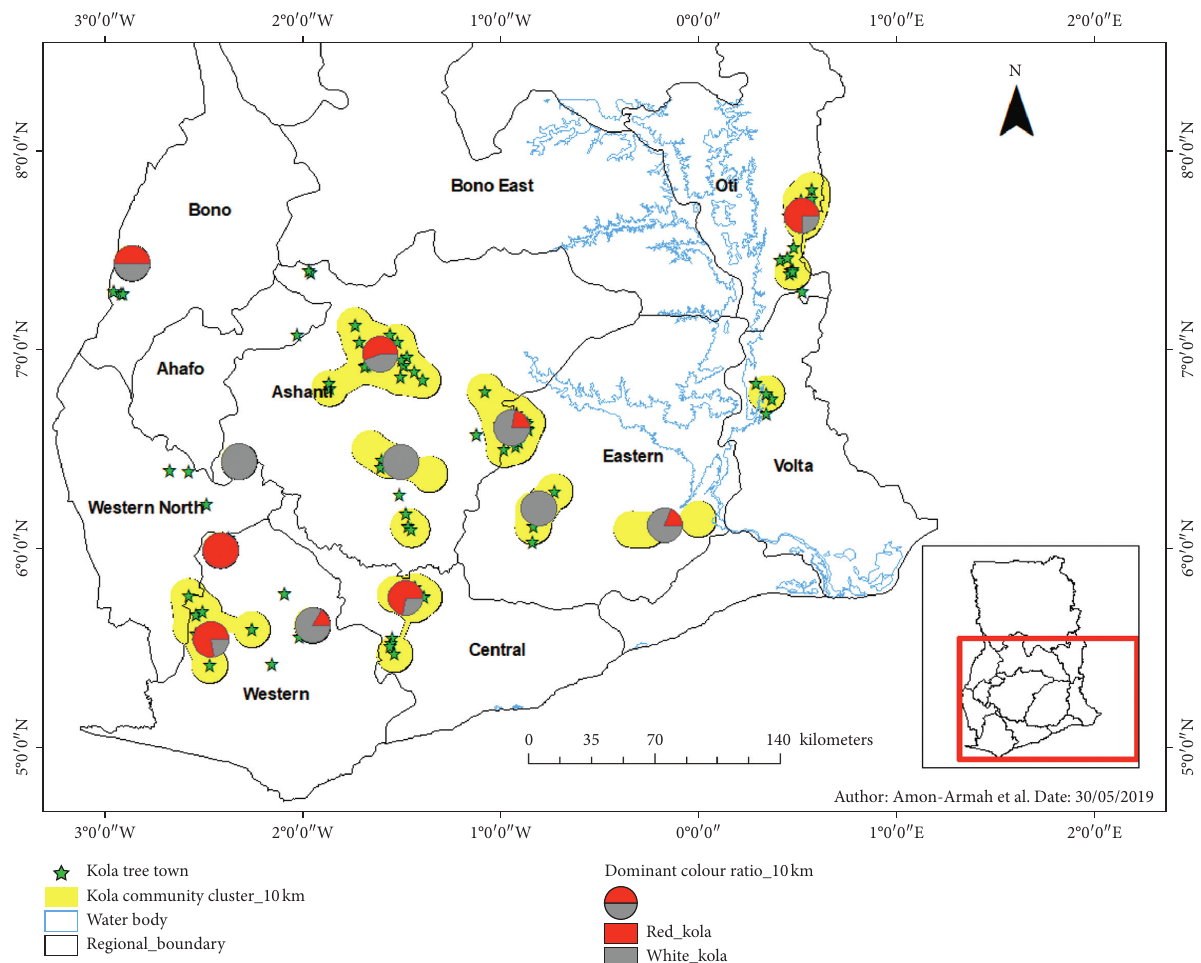
Figure 3: Map showing proportions of kola nut colour in clusters of 10km radius in the surveyed